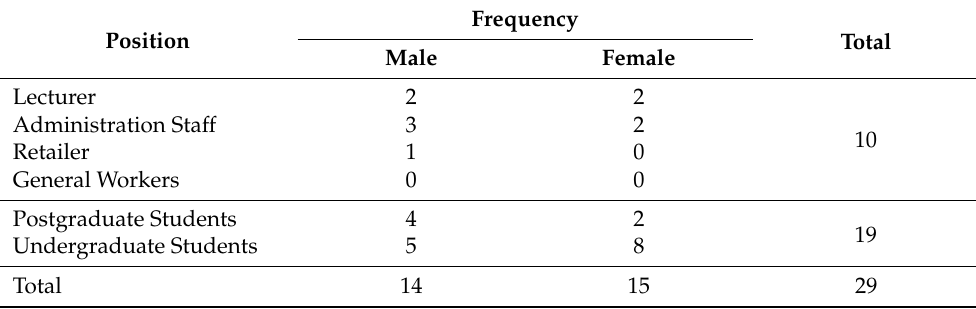
Table 2. Focus Group Discussion’s Respondent